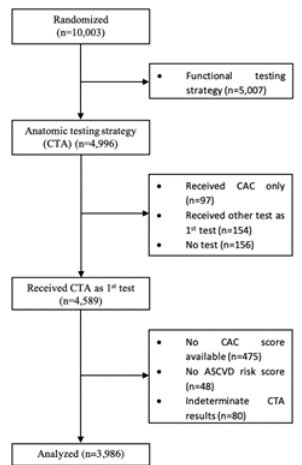
Figure 1. Patient Selection. CTA: Computed Tomography Angiography, CAC: Coronary artery calcium.